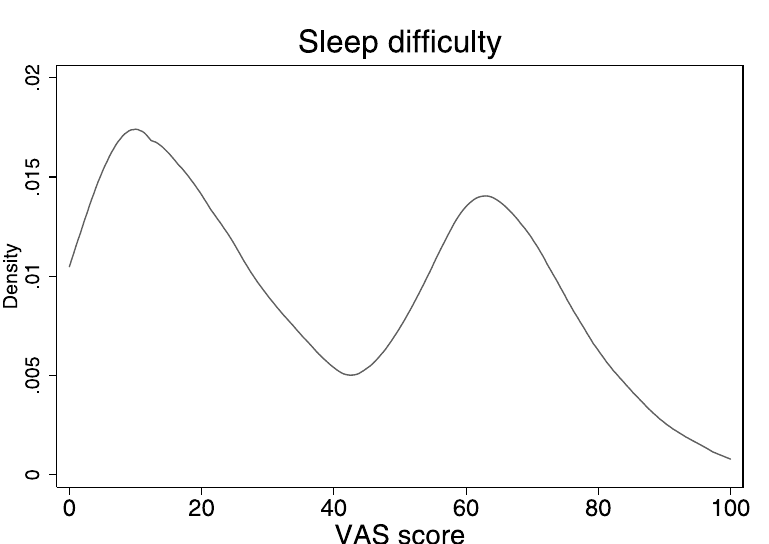
Fig 1. Distribution of sleep difficulty evaluations. Note : 0 means ‘no difficulty’ and 100 means ‘extreme difficulty’ with sleep.